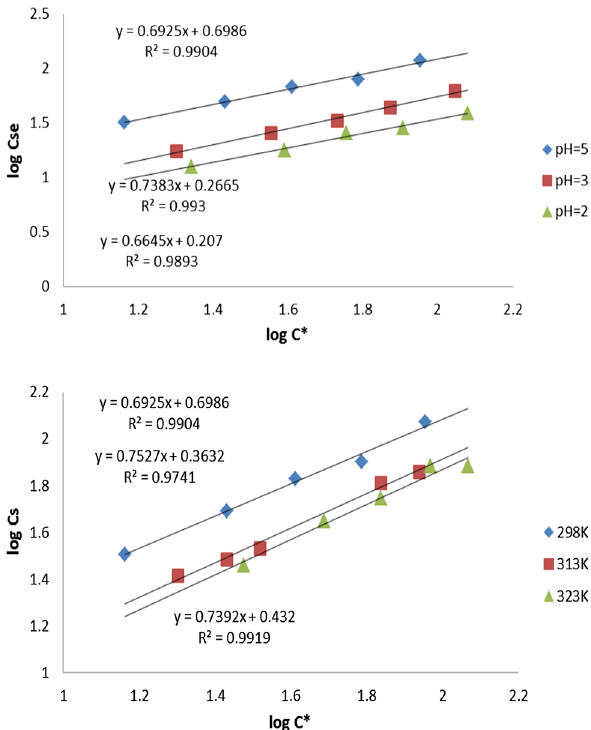
Fig. 7 Freundlich isotherms obtained for the biosorption of Cd(II) ions onto N. oculata biomass using Eq. (3)